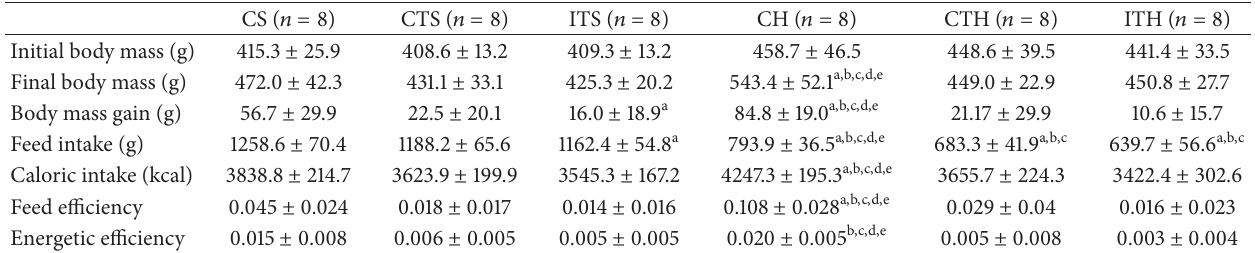
Table 3: Mean values of body mass, feed intake, caloric intake, and feed and energetic efficiency during the 8-week training period.